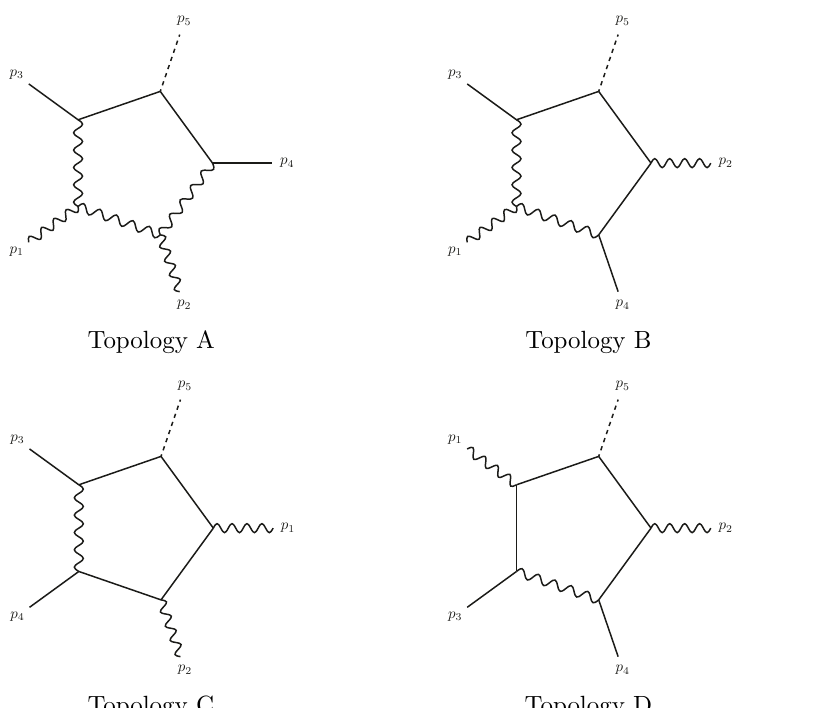
Figure 1 . The four independent integral families. Wiggly lines are massless; solid lines have mass m t ; and dashed lines have mass m H